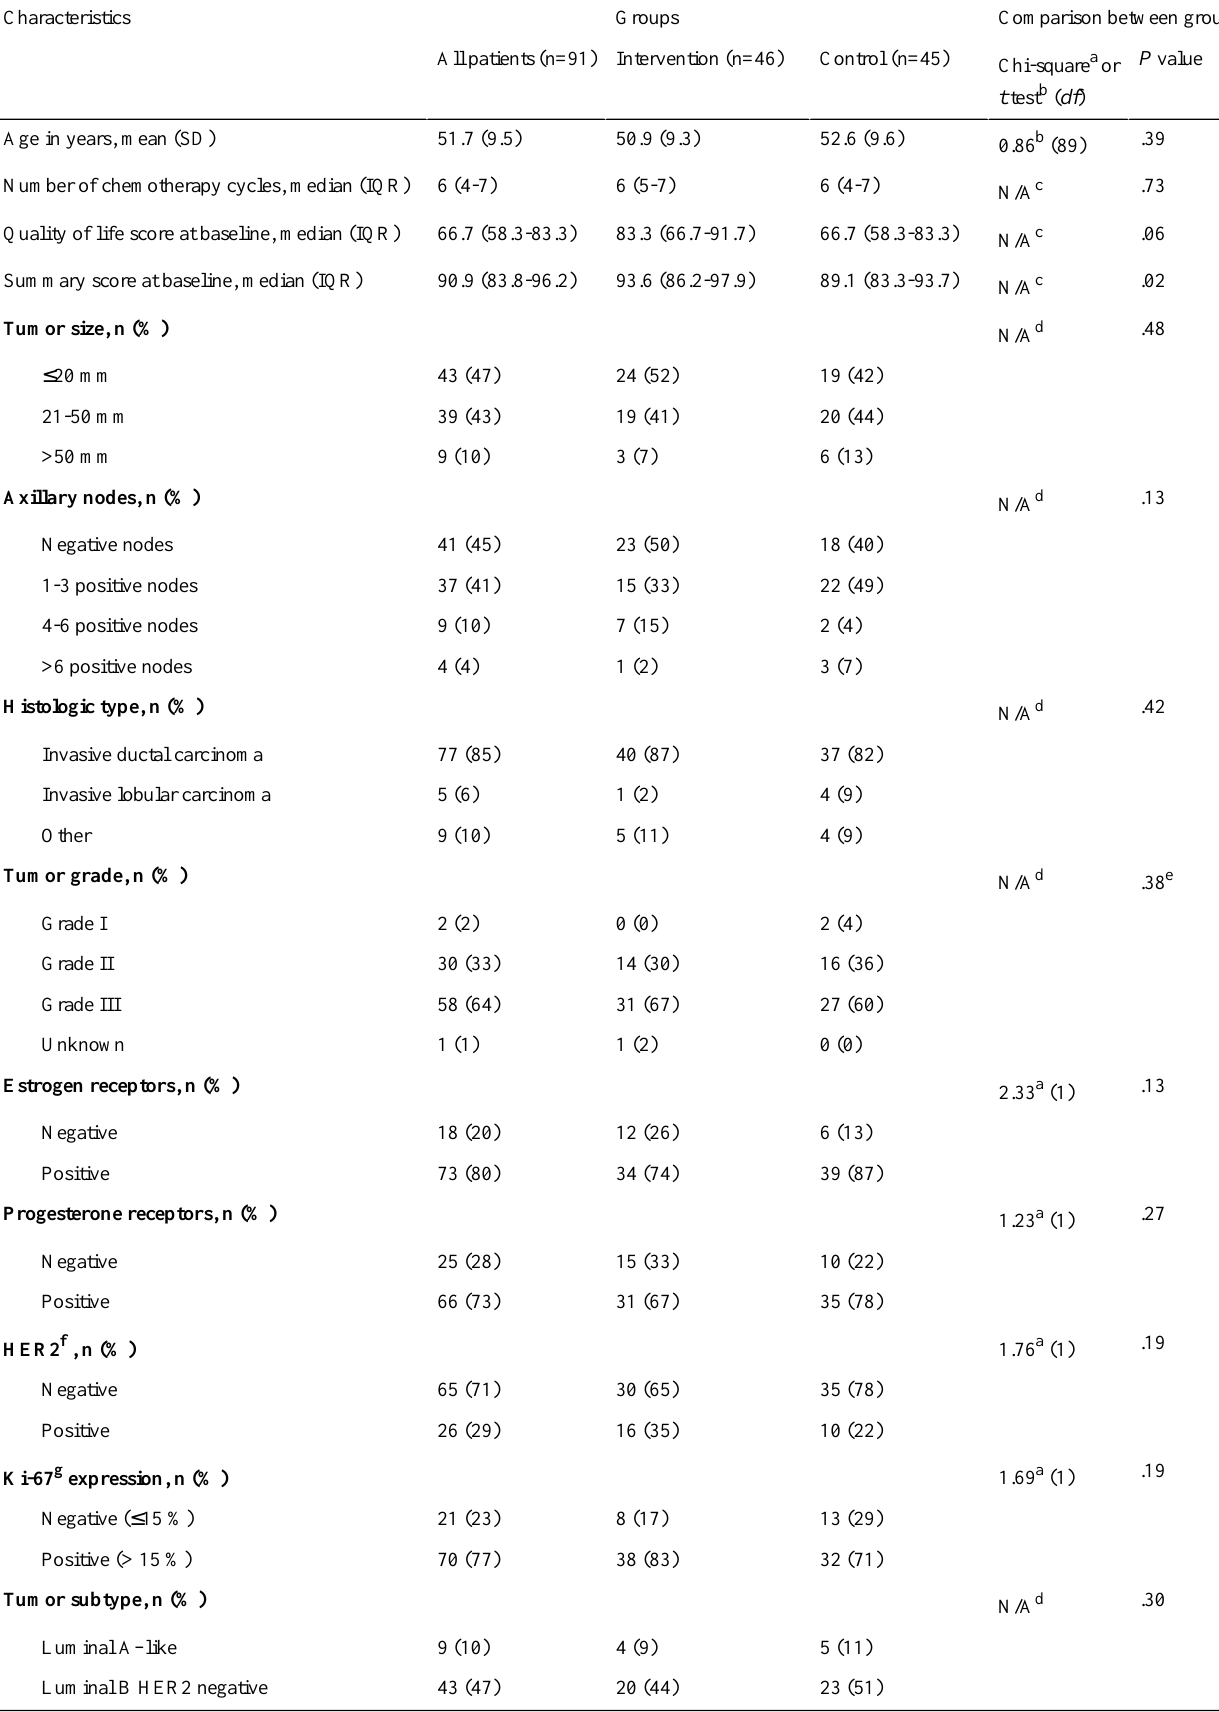
Table 1. Patient characteristics in the intervention and control group.